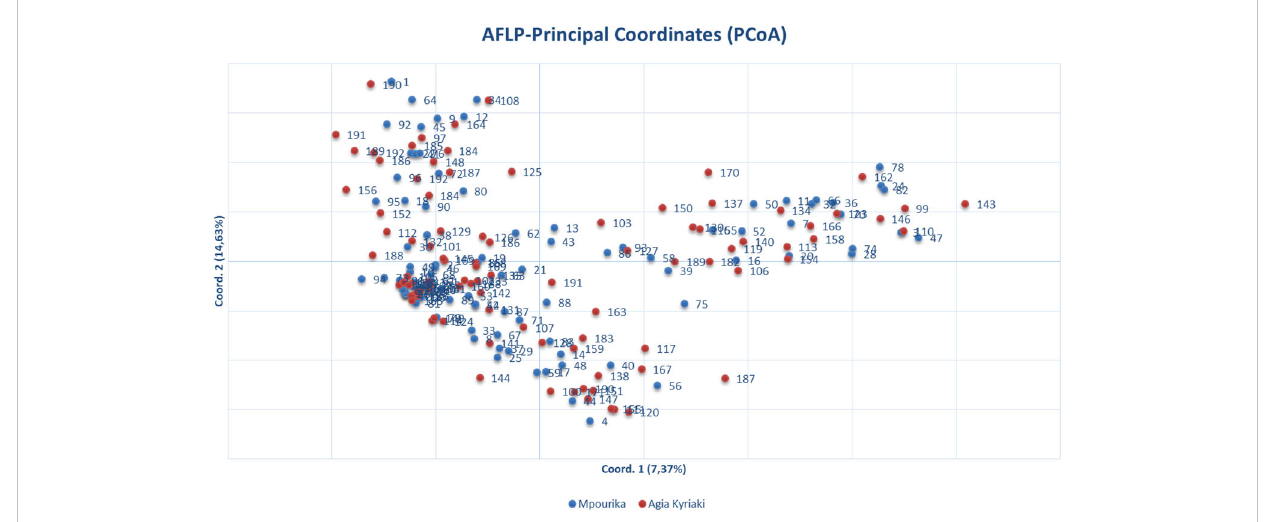
FIGURE 3 Principal coordinate analysis (PcoA) of genetic distances based on AFLP analysis of needle tissue in the exposed (Mpourika) and the control (Ag. Kyriaki)